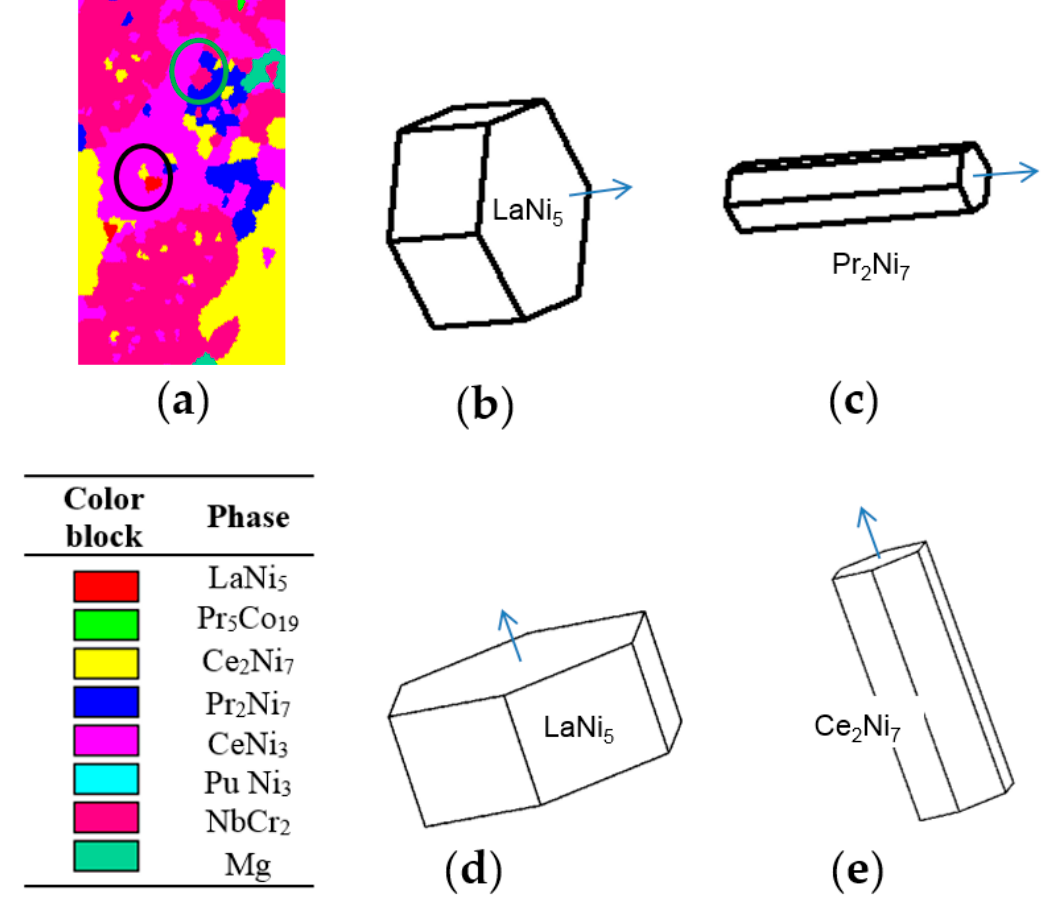
Figure 12. Crystallographic orientation alignments in [0001] demonstrated by ( a ) an IPF-EBSD map; orientations of ( b ) LaNi 5 and ( c ) neighboring Pr 2 Ni 7 in the green circle; and orientations of ( d ) LaNi 5 and ( e ) neighboring Ce 2 Ni 7 in the black circle of the 8-h annealed sample.